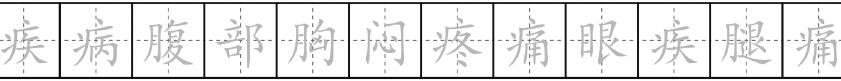
Figure 3. Schematic diagram of the Tianzi lattice.